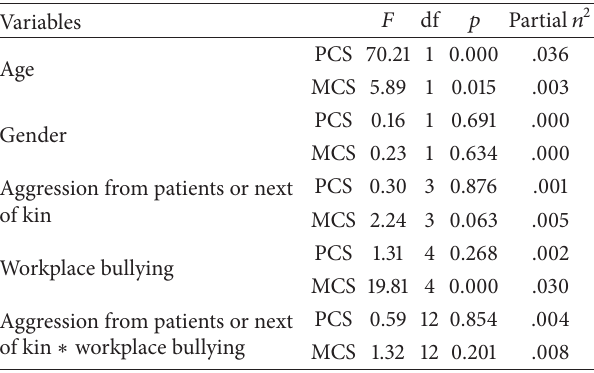
Table 3: Bivariate effects of aggression from patients or next of kin and workplace bullying on health-related quality of life outcomes, from the MANOVA